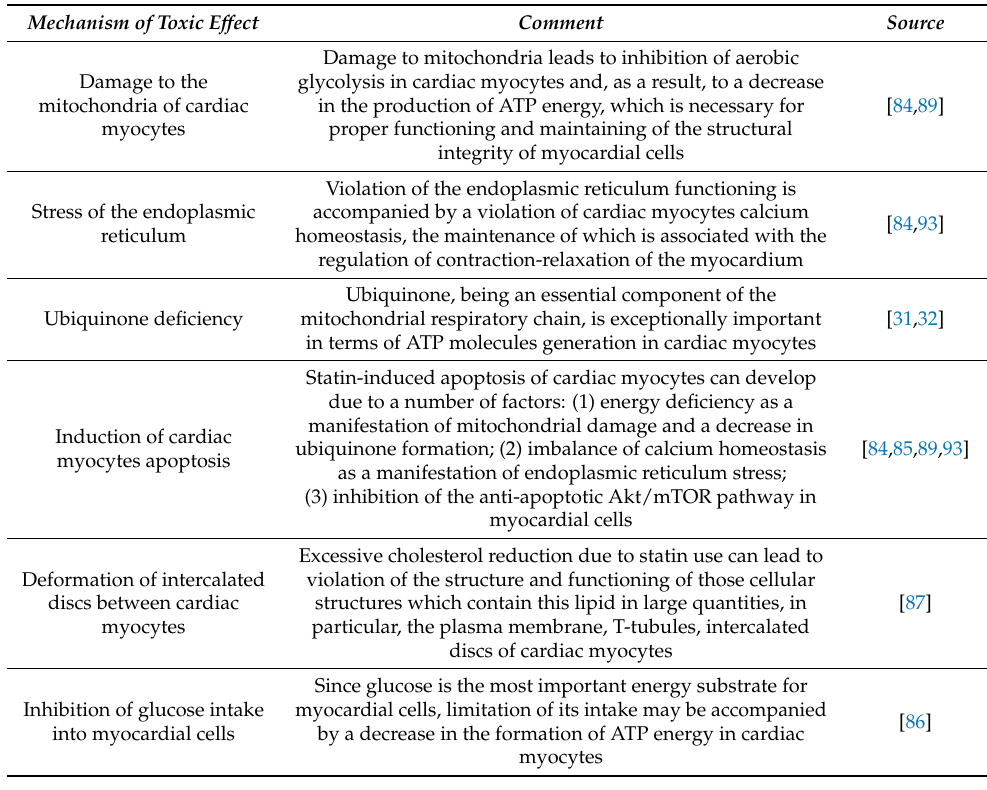
Table 3. Main possible mechanisms of statins’